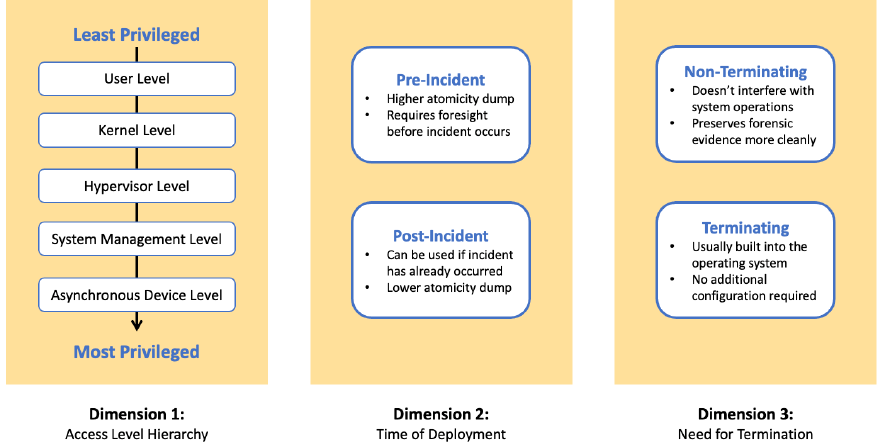
Figure 1. Taxonomy for memory acquisition methods as defined by Latzo et al.